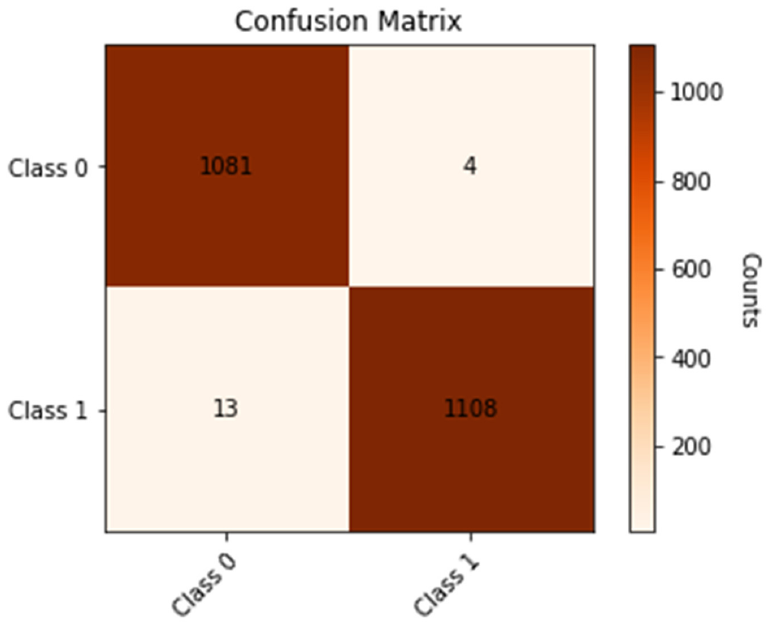
Figure 9. Confusion matrix of the proposed method to detect AD for binary classification tasks .